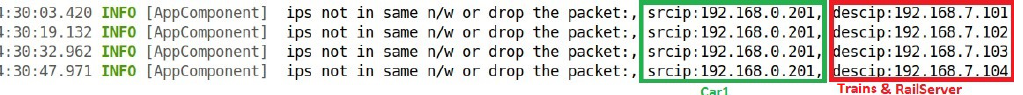
Figure 22. Screenshot of SDN application log: ping from Car1 to Train1, Train2, Train3, and RailServer.